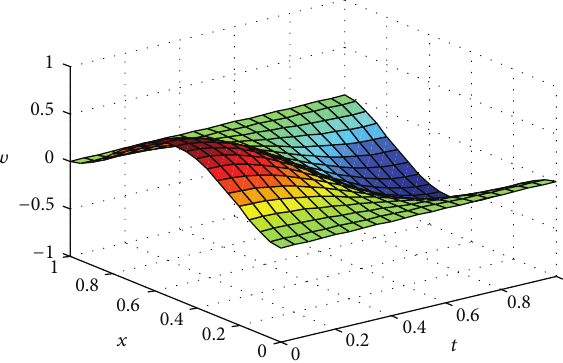
Figure 1: The state without damping control; that is, 𝑢 = 0